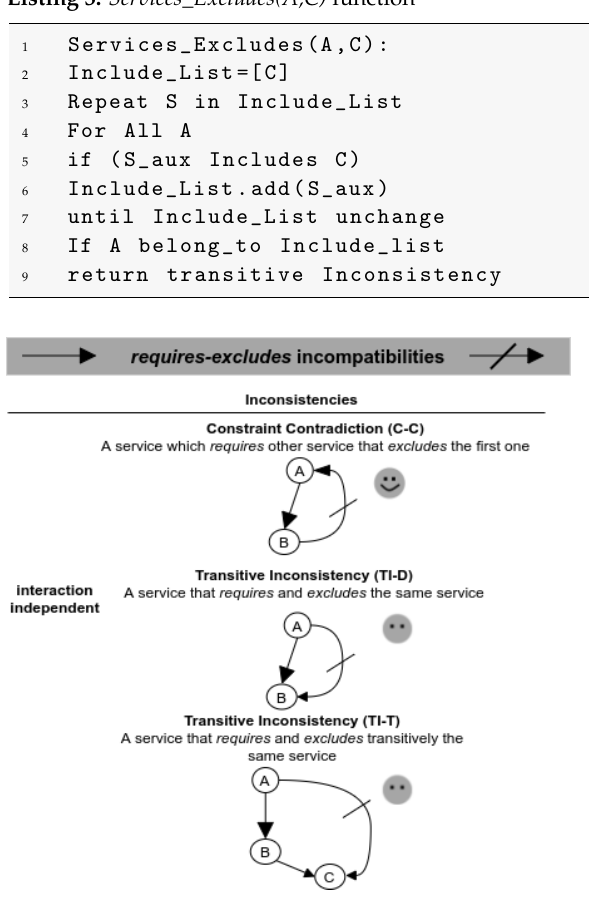
Figure 11. Validation scenarios involving requires-excludes